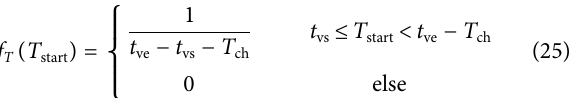
Frontiers in Energy Research |